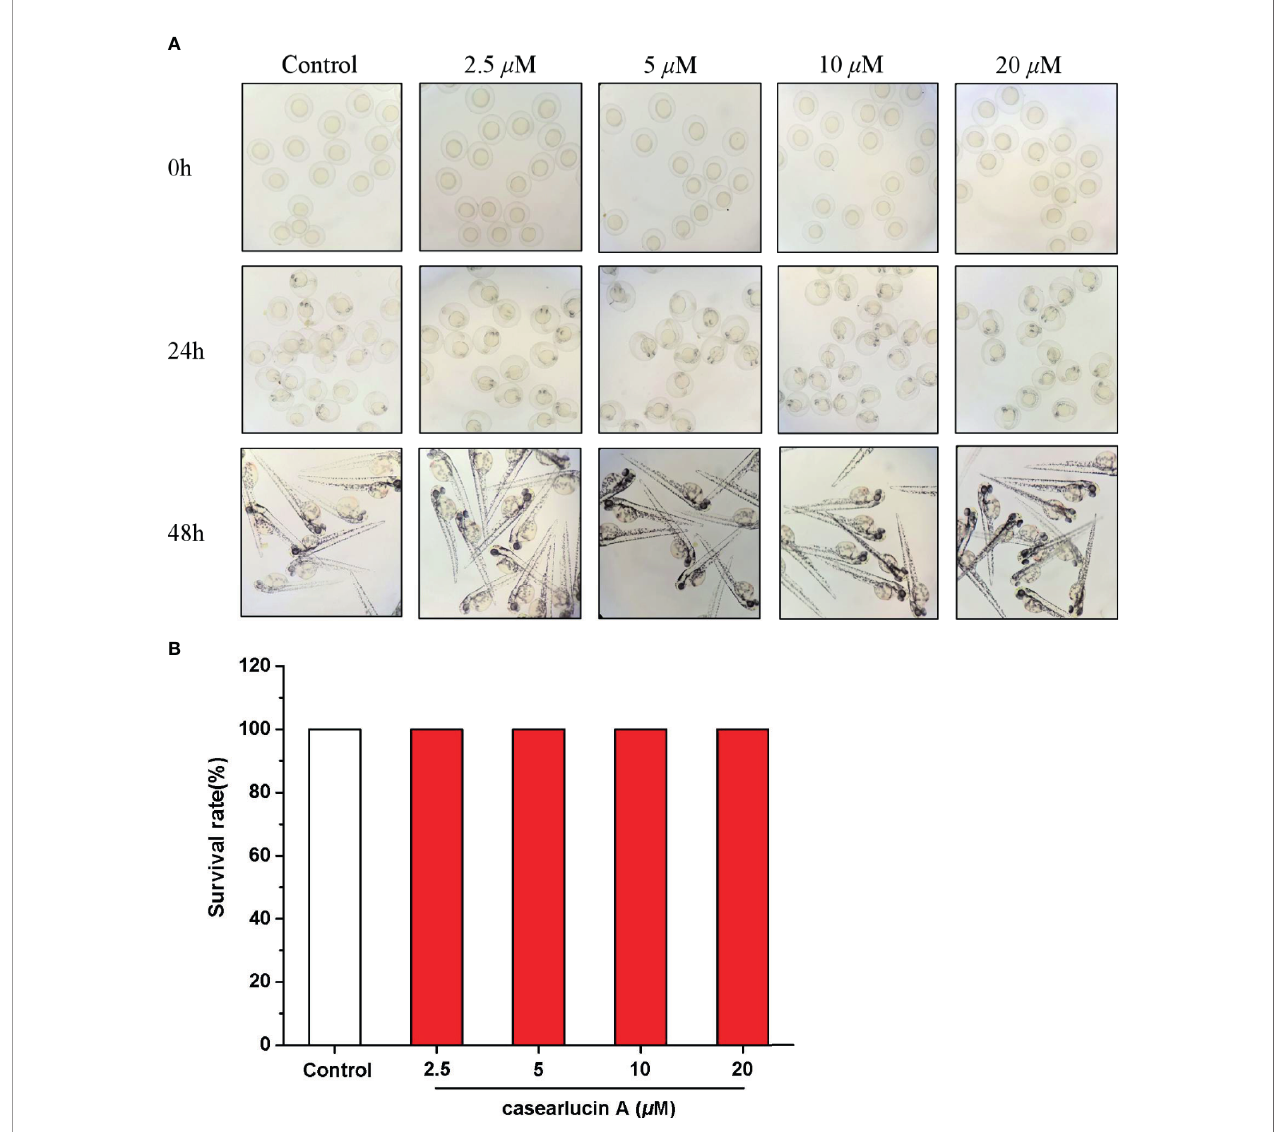
FIGURE 7 | Developmental toxicity of casearlucin A in Zebra fi sh Embryos. The zebra fi sh embryos were treated with casearlucin A (2.5, 5, 10, and 20 m M) for 48 h. (A) The morphology of zebra fi sh. (B) The survival rate of zebra fi sh. DMSO was used as a negative